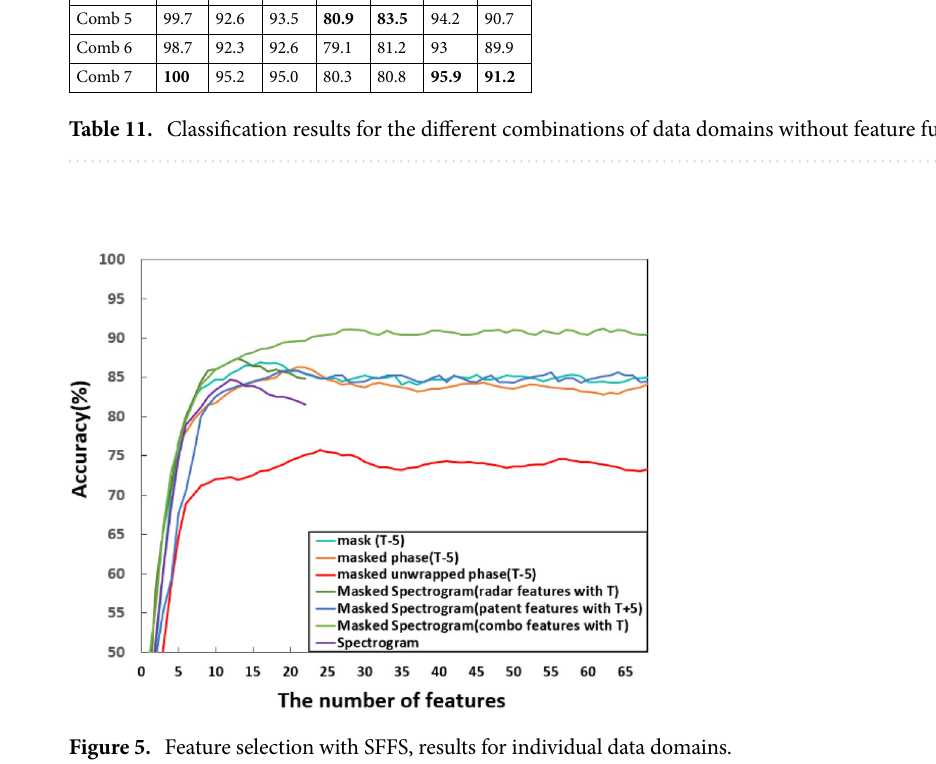
Figure 5. Feature selection with SFFS, results for individual data